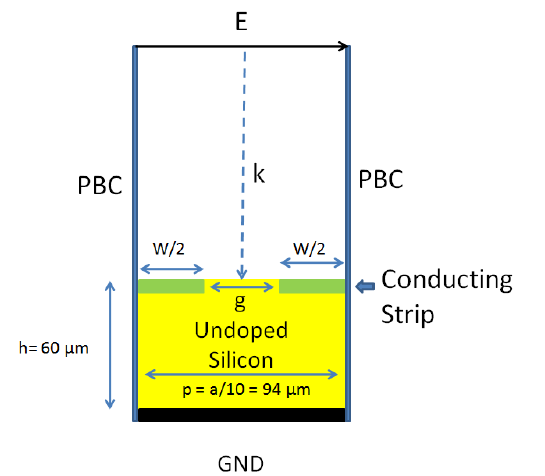
Figure 3: Geometry of a unit cell in a grounded silicon slab loaded by infinite periodic conducting